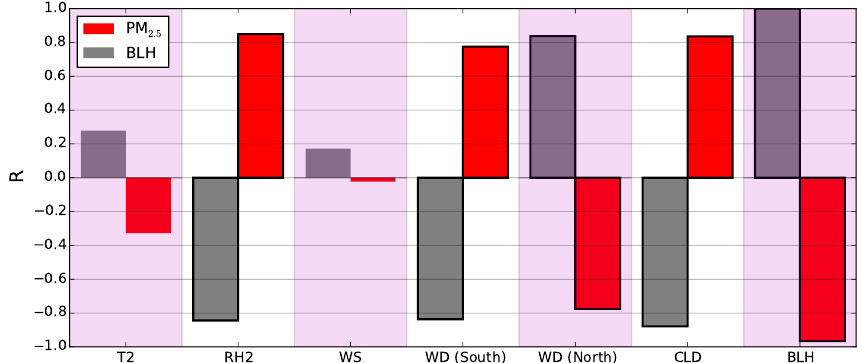
Figure 8. Correlations ( R ) between the mean values of PM 2 . 5 concentration and meteorological parameters for the different synoptic patterns, including (from left to right) 2m temperature (T2), 2m relative humidity (RH2), wind speed at the 925hPa level (WS), south- and north- wind frequencies at the 925hPa level (WD), total cloud cover at 14:00BJT (CLD), and the BLH at 14:00BJT. The grey bars represent the correlations between BLH and these meteorological parameters. Bars outlined in thick black lines indicate correlation coefficients ( R ) that are statistically significant ( p < 0 . 05). Note that the R is calculated based on the seven pairs of mean values for different synoptic patterns.